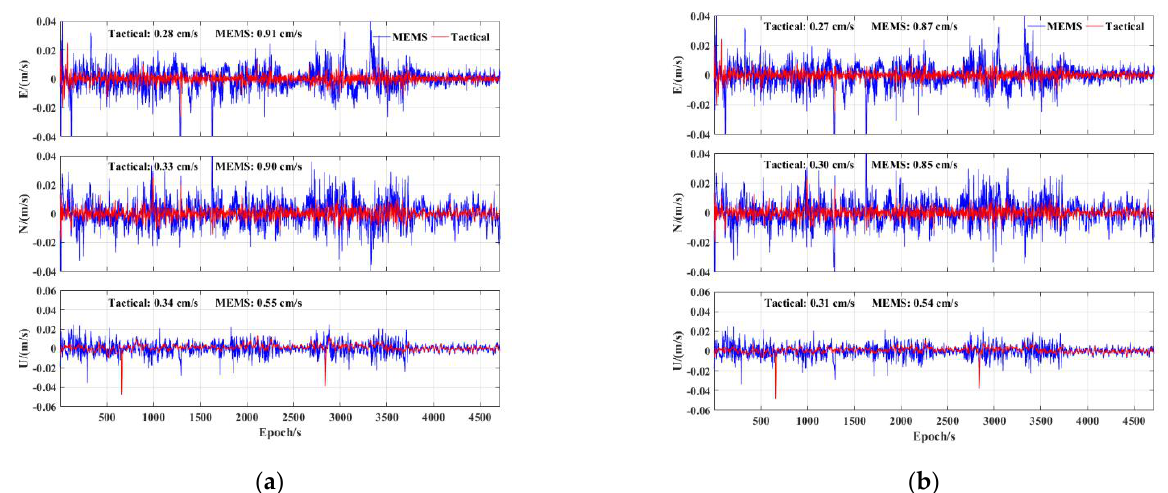
Figure 11. PPP/INS tight integration velocimetry error of tactical IMU and MEMS IMU: ( a ) BDS − 3 PPP − B2b RT corrections; ( b ) GFZ post − precise products.